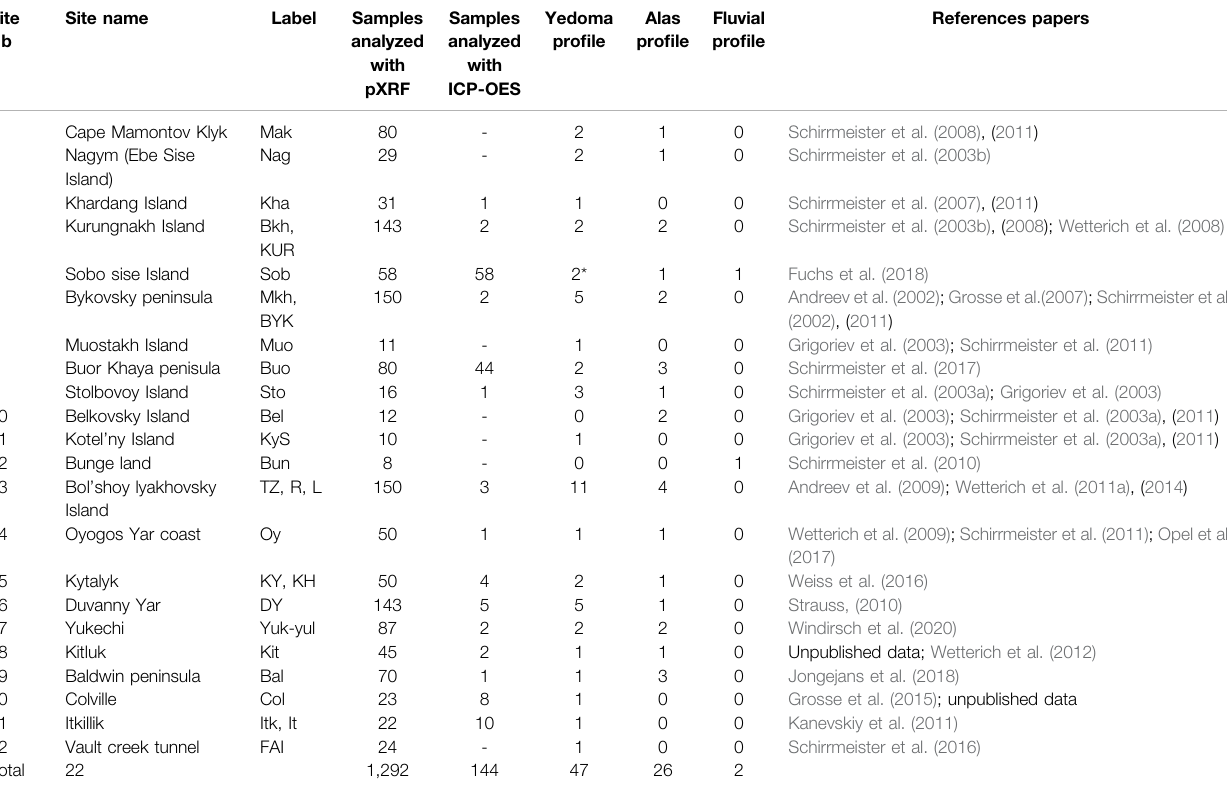
TABLE1| ListofthestudiedsitesfromtheYedomadomain,associatedlabel,numberofsamplesanalyzedwithportableX-ray fl uorescenceandinductivelycoupledplasma optical emission spectrometry method, number of pro fi les sampled for each type of deposits and associated reference papers. Sites are located in Siberia (1 – 17) and Alaska (18 – 22). The site numbers 1 to 22 are located on the map in Figure 2 . * Sobo Sise pro fi les are of Holocene age on top of Yedoma Ice Complex deposits. Labels identi fi cation for each pro fi le are detailed in Supplementary Table S1 . Site